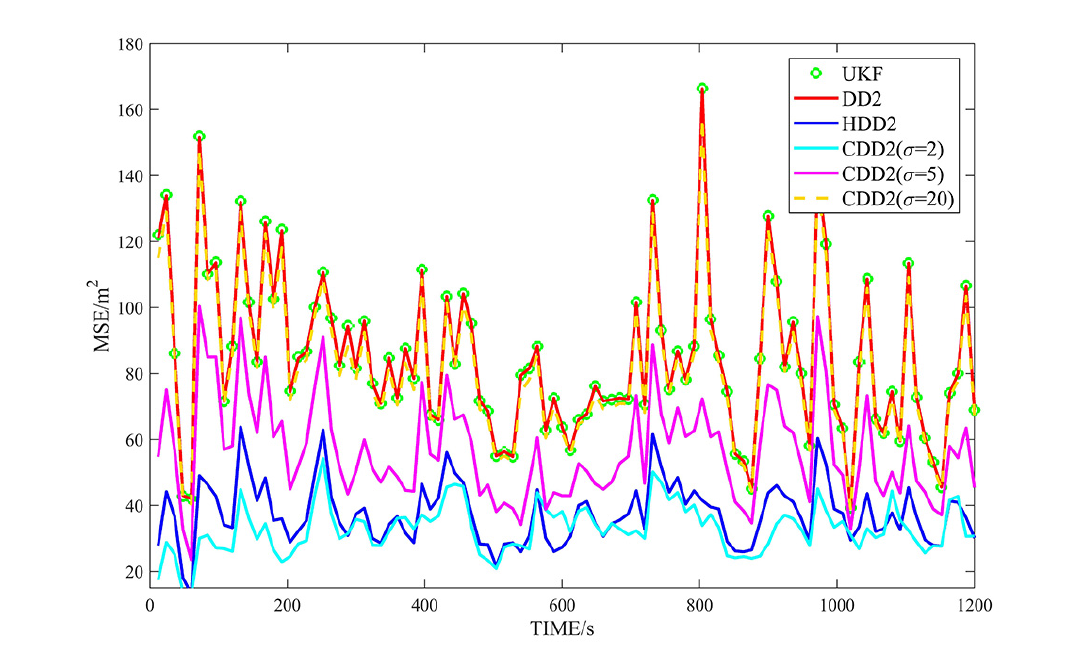
Figure 5. MSEs of λ with second-order approximate filters in non-Gaussian